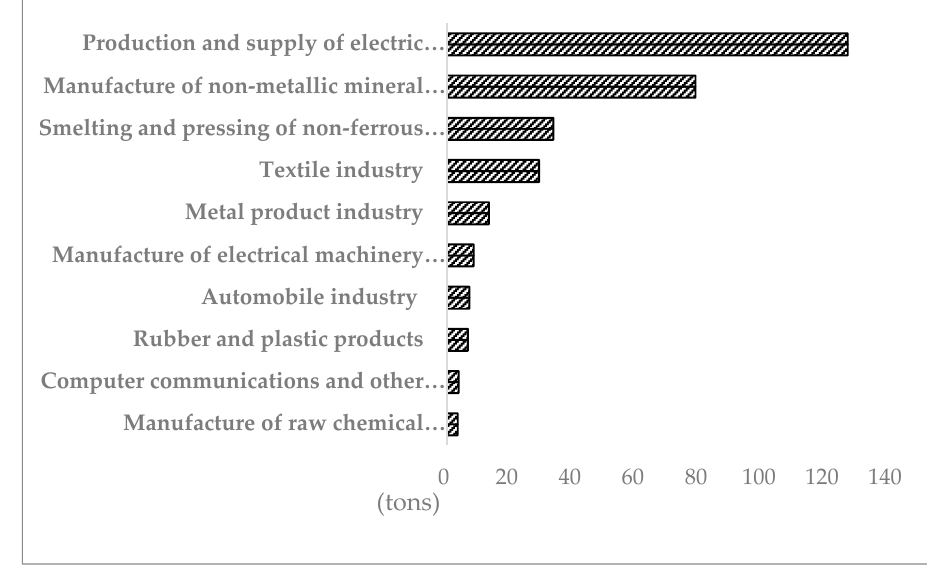
Figure 11. ICECADS by industry (top 10).